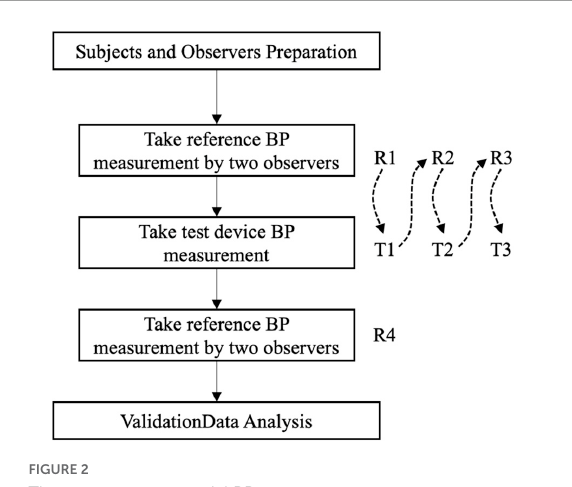
FIGURE2 The same arm sequential BP measurement process.